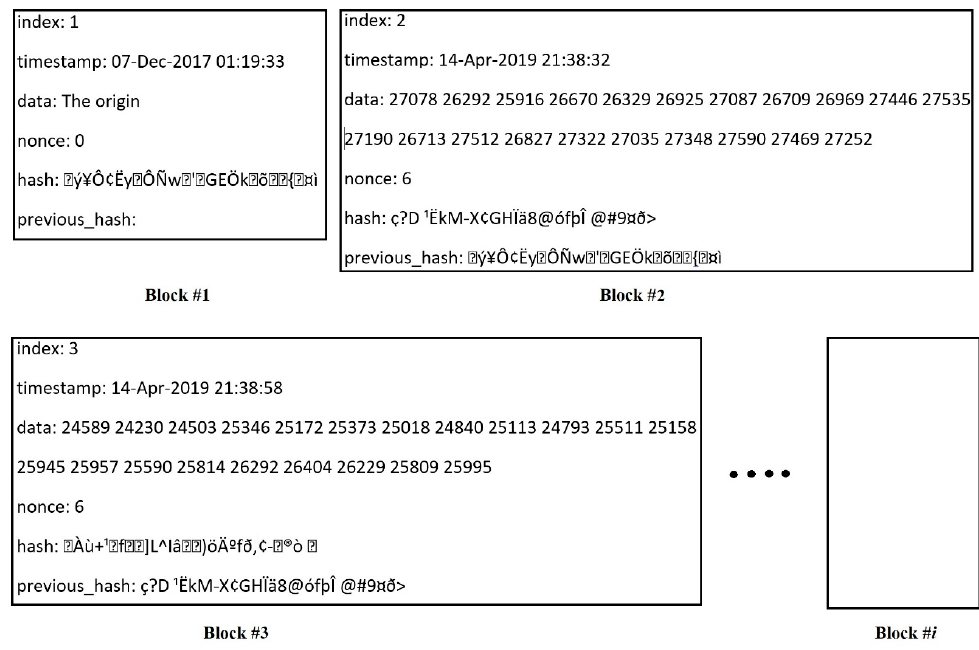
Figure 7. The generated blockchain.